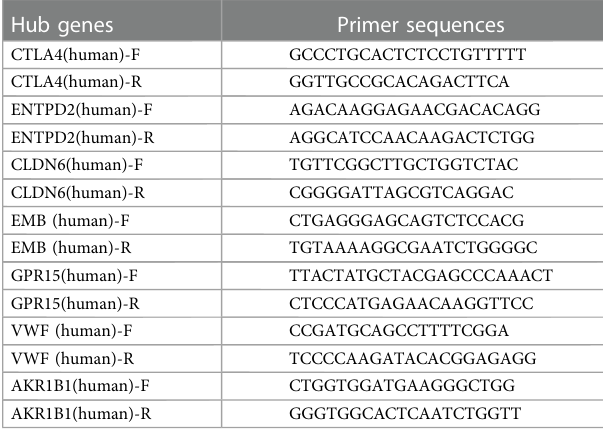
TABLE 1 Primer sequences of 7 hub